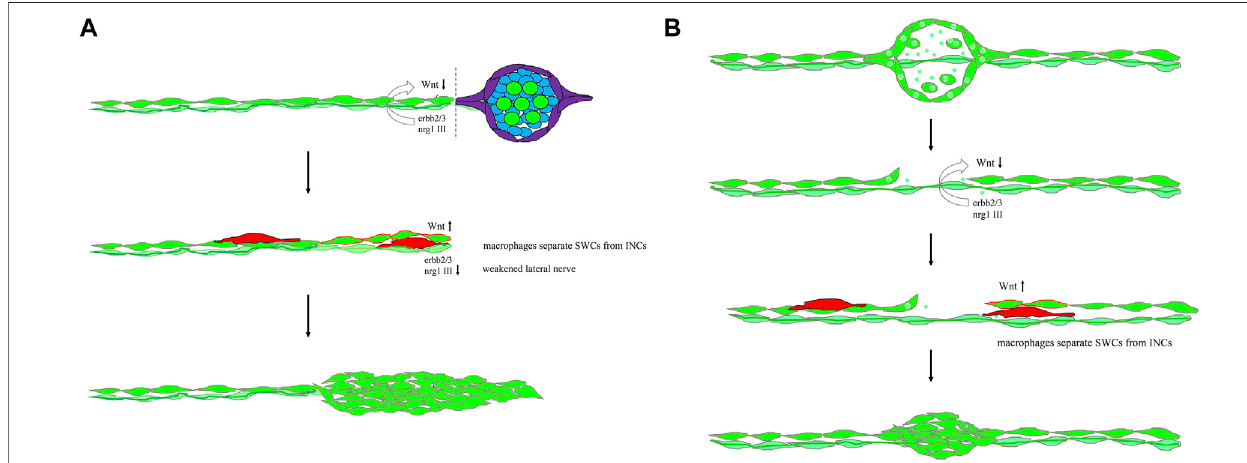
FIGURE 9 | Mechanistic models for lateral line regeneration. (A) Under normal conditions, the pLLn (thick dark green thread) nrg1-III-activated erbb2/3 receptors within Schwann cells (SWCs, light green) keep interneuromast cells (INCs, bright green) quiescent by limiting the Wnt activity. Upon the loss of distal neuromasts by tail amputation,thelaterallinenerveisweakened(thinlightgreenthread)intheproximityofthecuttingedgetobreakthequiescenceofINCs(redoutlines).TheWntactivityin INCs is elevated and results in cluster formation. (B) Upon speci fi c ablation of neuromasts by NTR-hKikGR protein (bright green spots)-induced by Mtz without damaging surrounding posterior lateral line nerve and SWCs, INCs remain quiescent by integral EGF inhibition. Most macrophages crawl onto INCs, fi lling the gap without successful neuromast regeneration. However, occasionally macrophages could in fi ltrate in between INCs and SWCs. It breaks the contact between INCs and SWCs and the inhibition of EGF signaling. INCs are then activated to be able to differentiate and regenerate new neuromasts through cluster formation.